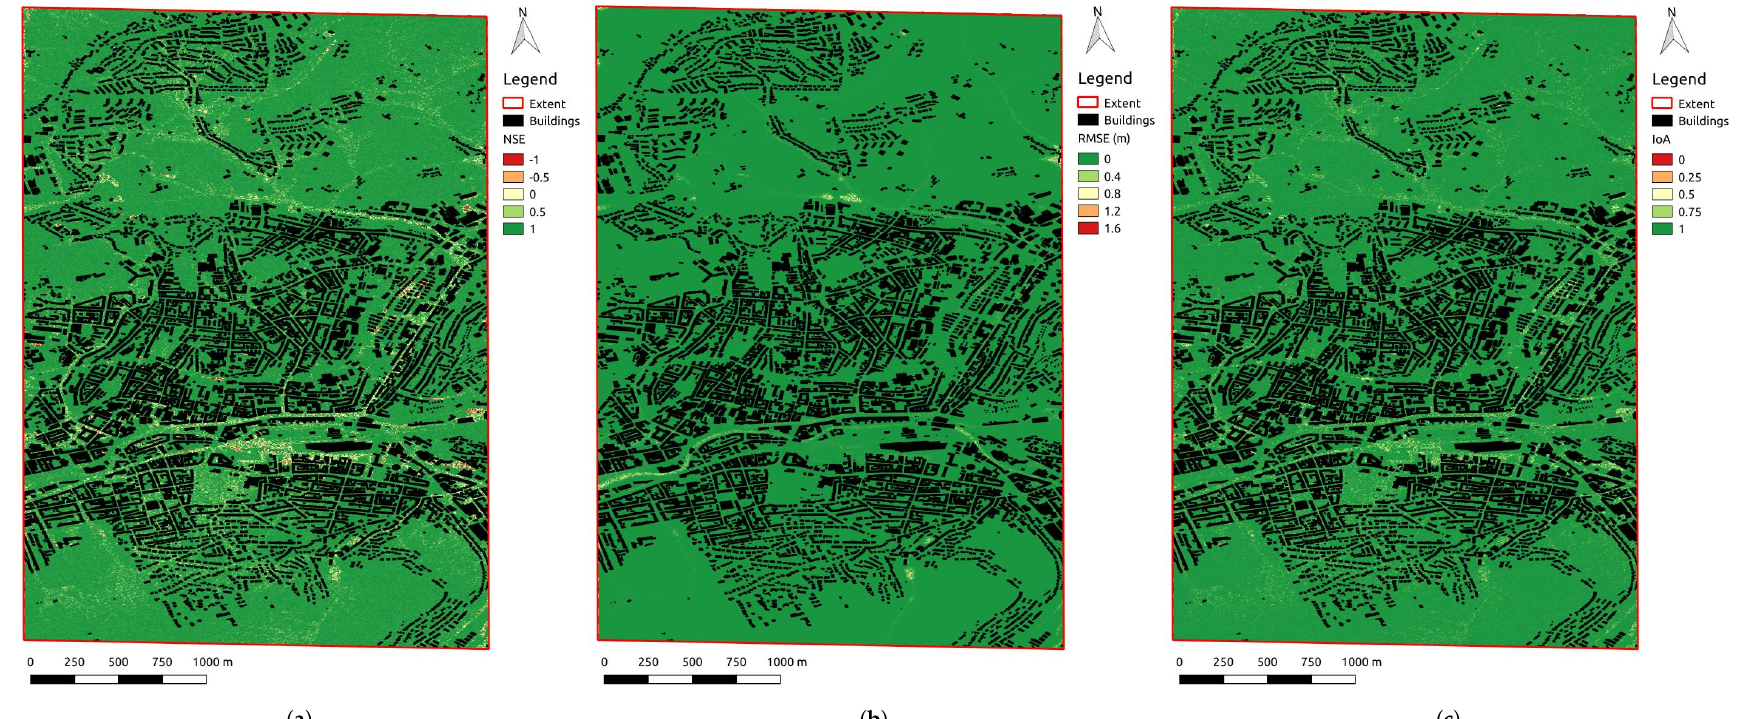
Figure 7. Spatial distribution of model performance for water depth. Green indicates very good or perfect agreement. ( a ) NSE; ( b ) RMSE; ( c )